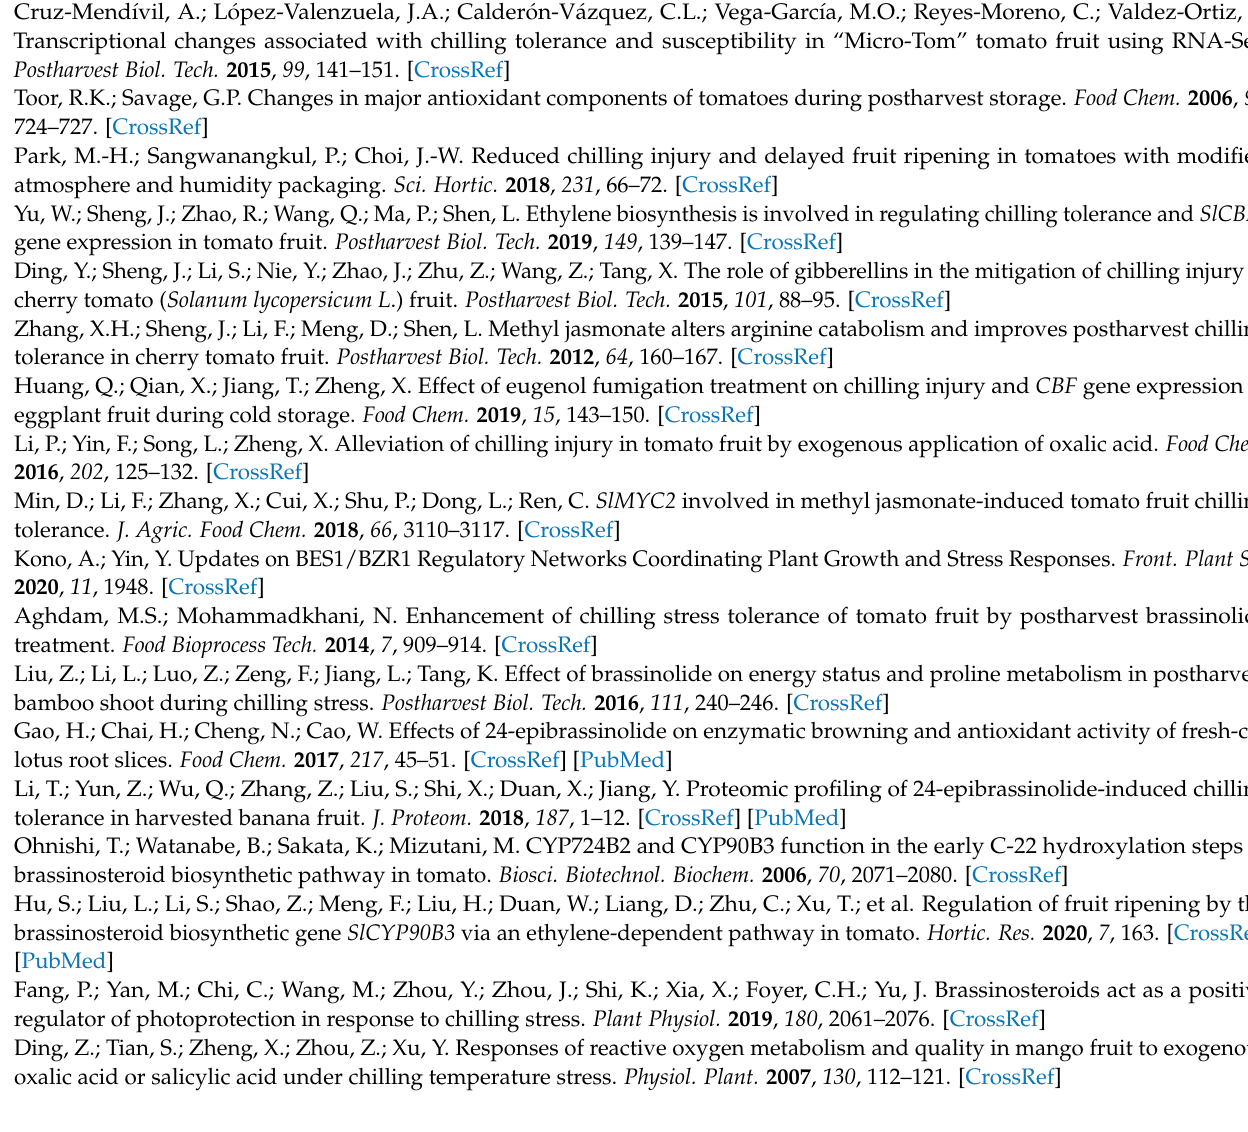
analysis, Figure S1: Chilled pitting on the surface of postharvest tomato fruits, Figure S2: SlCYP90B3 overexpression promoted the expression of BR biosynthetic genes during 24 h of cold